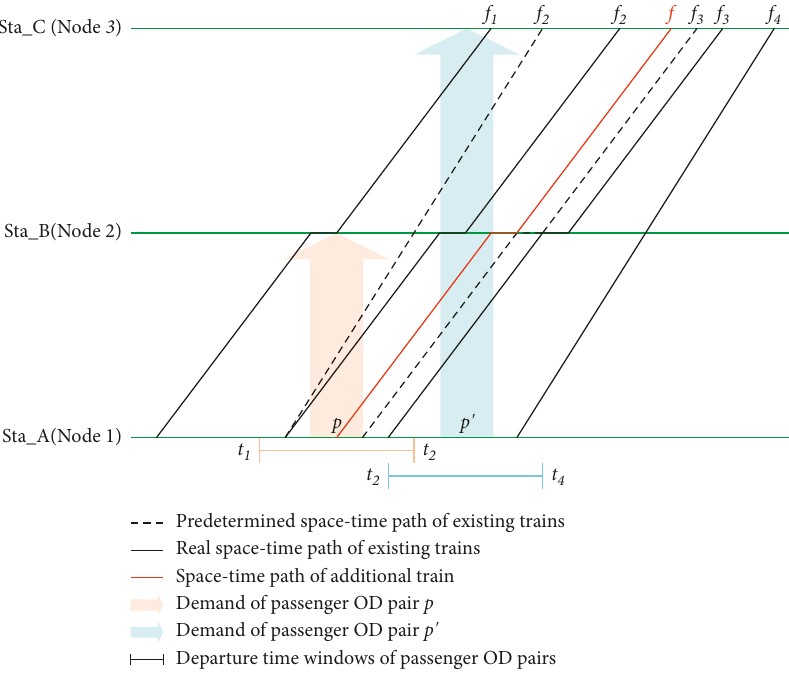
Figure 2: An illustration of rescheduling operation plan in time-space